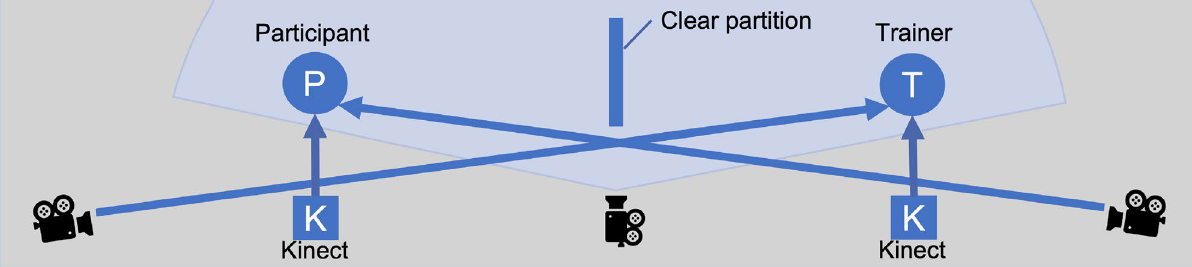
Figure 2. Top view of recording device map 12 .